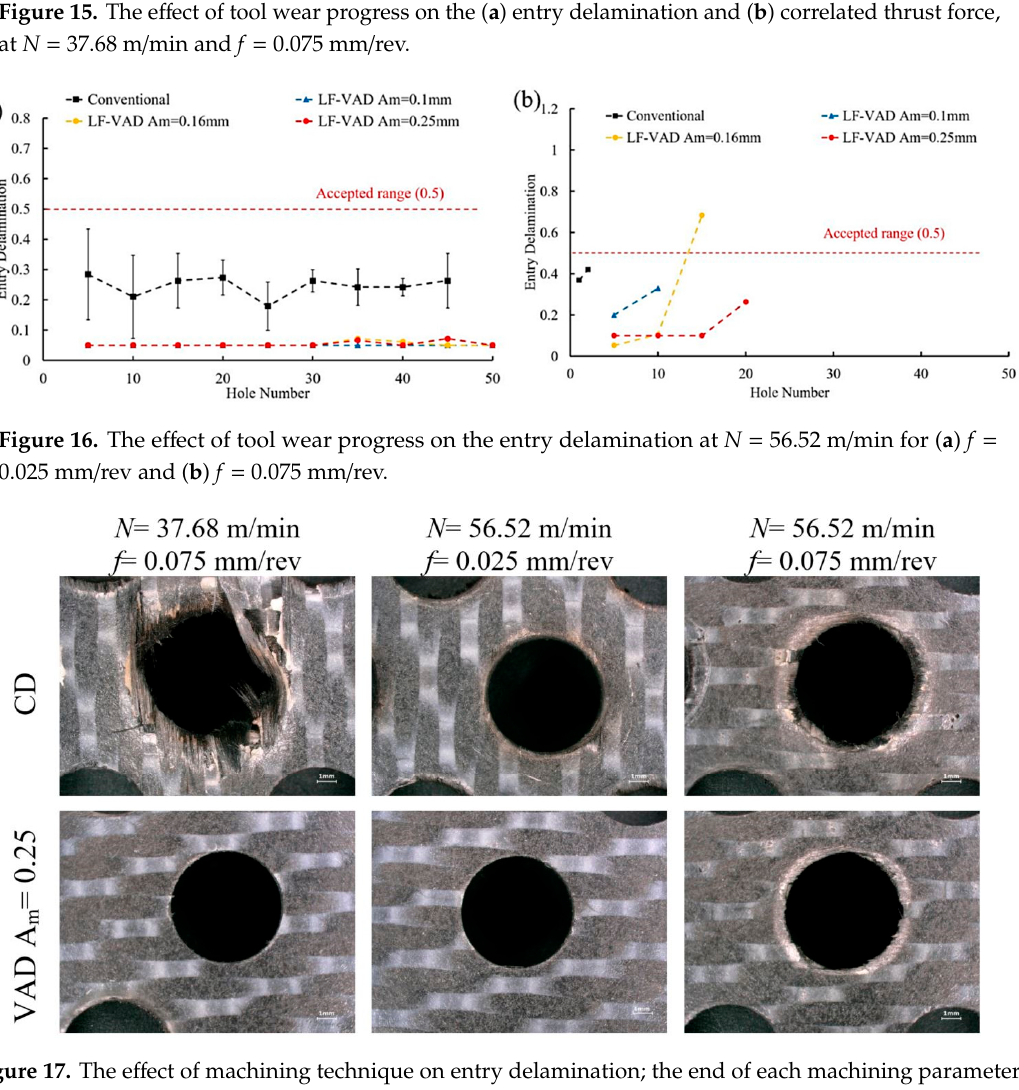
Figure 17. The effect of machining technique on entry delamination; the end of each machining parameter.